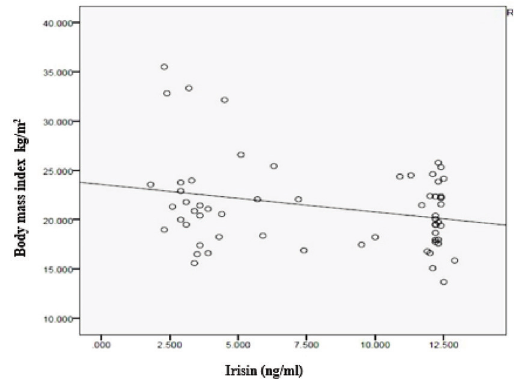
Figure 2 . Inverse and significant correlation between BMI and irisin level ( P =0.03, r=-0.26).